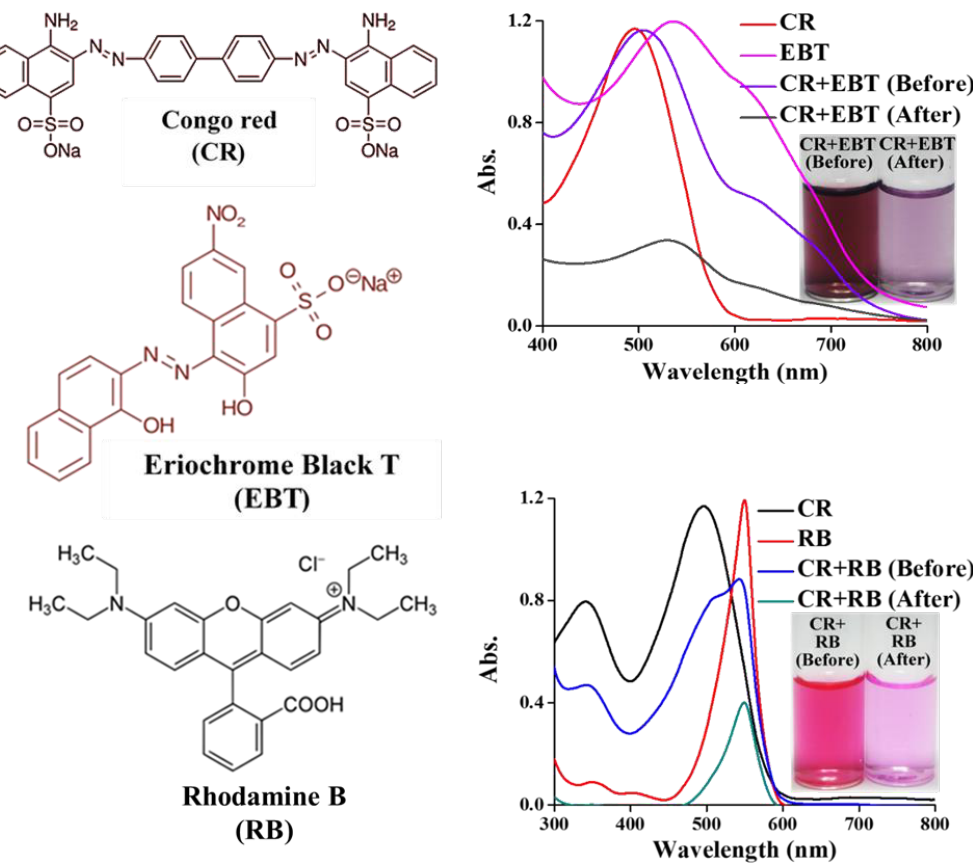
Appl. Sci. 2020 , 10 , x FOR PEER REVIEW Figure 10. The selective removal of CR dye with other organic dyes under pH 7. Figure 10. The selective removal of CR dye with other organic dyes under pH 7.